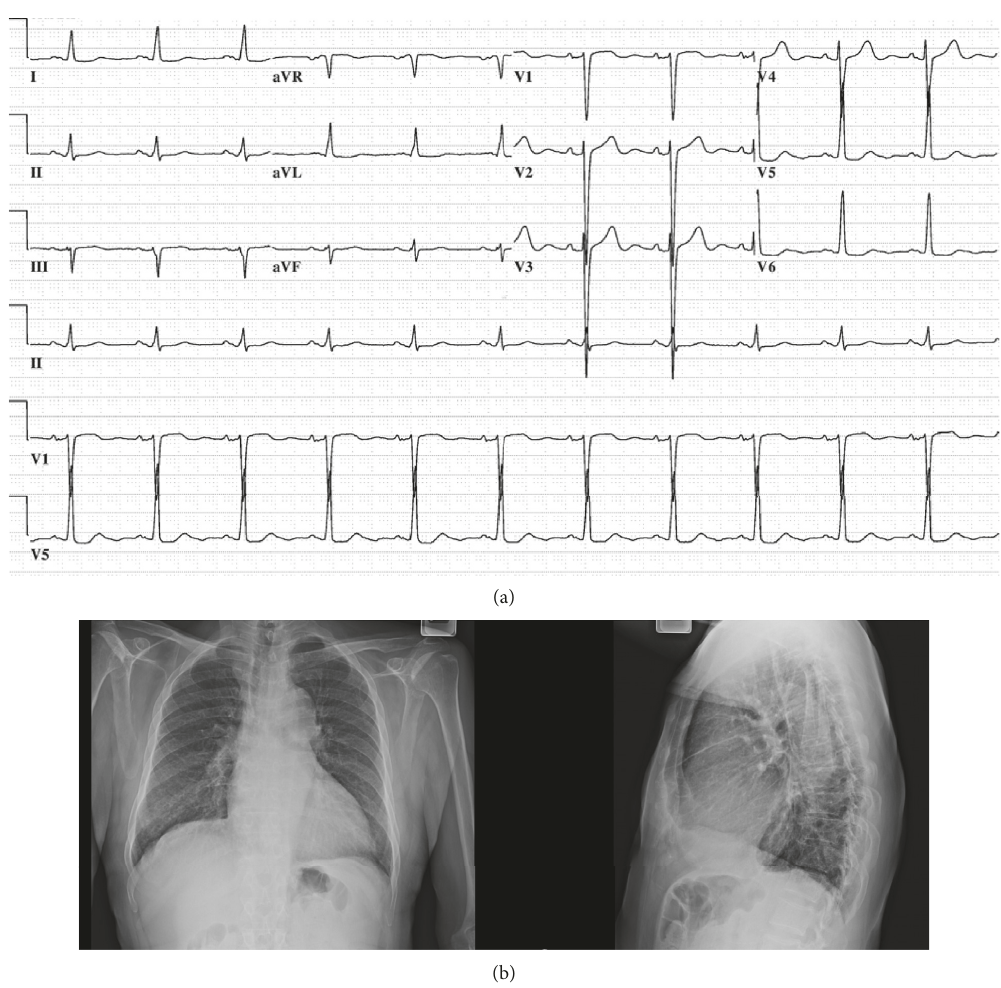
Figure 1: (a) 12-Lead electrocardiogram: ECG demonstrating sinus rhythm with left ventricular hypertrophy based upon Cornell voltage criteria. (b) Anteroposterior and lateral chest x-ray: demonstrating mild cardiomegaly, a tortuous aorta, and mild interstitial prominence greatest at the right lung base.